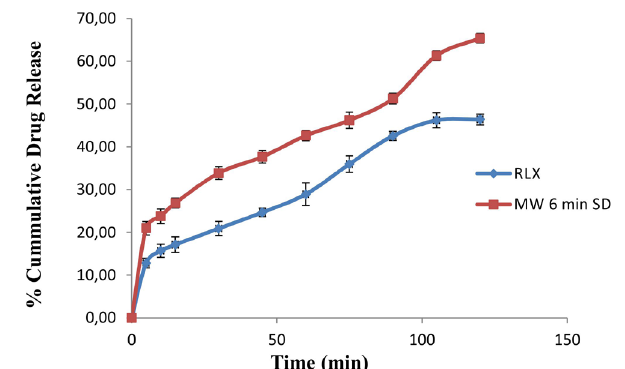
Table III. The maximum enhancement in the dissolution rate is 65.42% ± 0.39%, at 120 minutes.